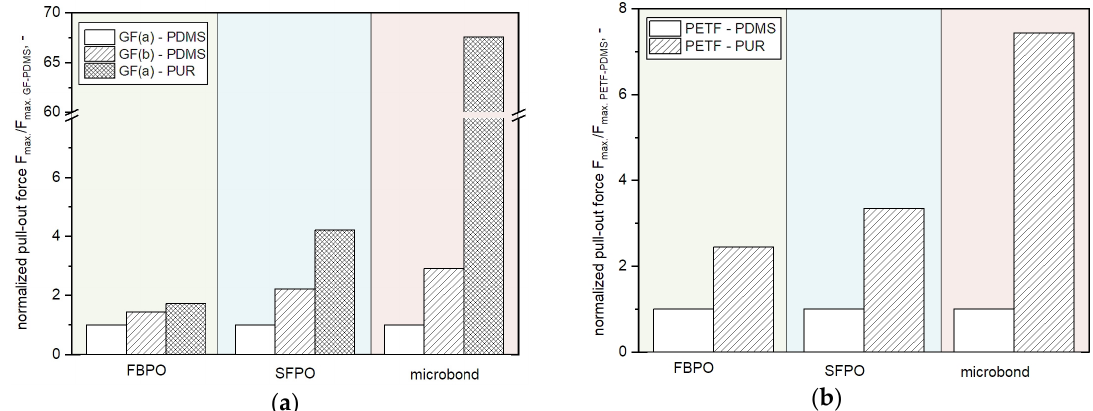
Figure 5. Comparison of the relative pull-out force for FBPO, SFPO and microbond tests performed with different fiber-matrix combinations with GF ( a ) and PETF ( b ).